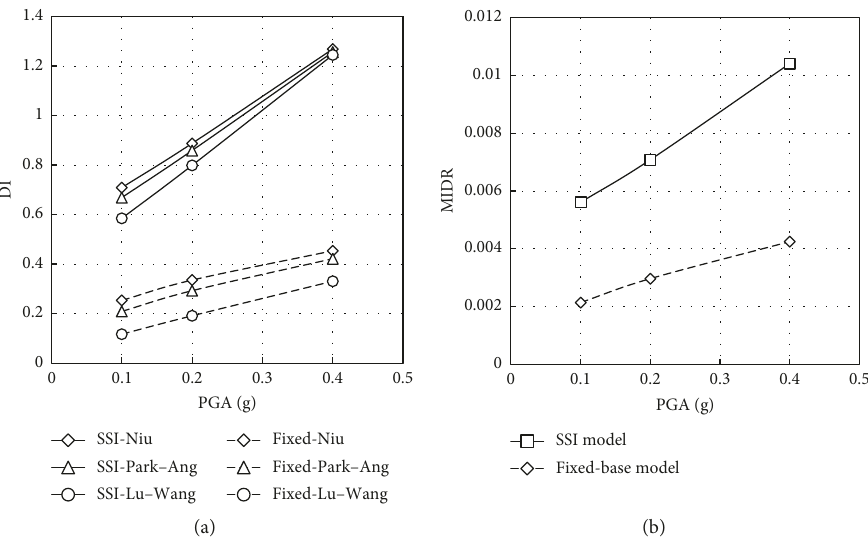
Figure 8: Distribution of the global damage index under different intensities of seismic ground motions with DPDMs (a) and the MIDR